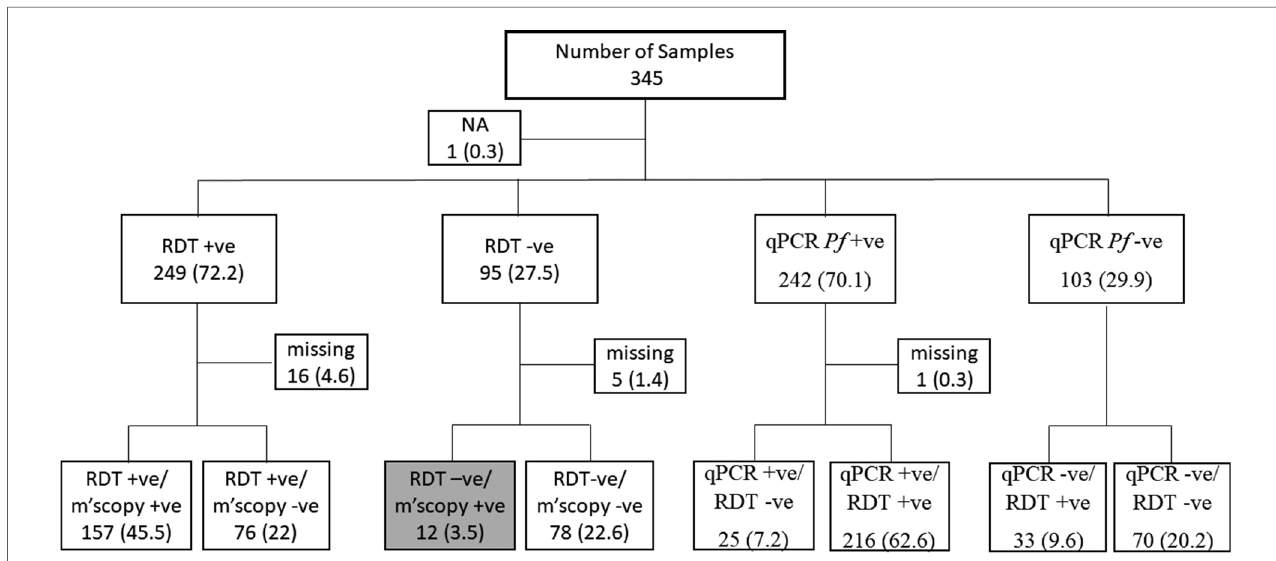
FIGURE 1 The sample selection criteria for the study. Samples were selected based on RDT the routine malaria diagnostic test conducted at health facilities. Thus, 12 discordant samples were RDT negative but positive by microscopy (grey box). Sample selection was also based on qPCR results following a routine assessment done within this study. NA, sample with no RDT data; Missing, samples with RDT but no microscopy data or qPCR but no RDT data. The values in brackets represent the frequencies of the respective categories relative to the overall sample size of 345.